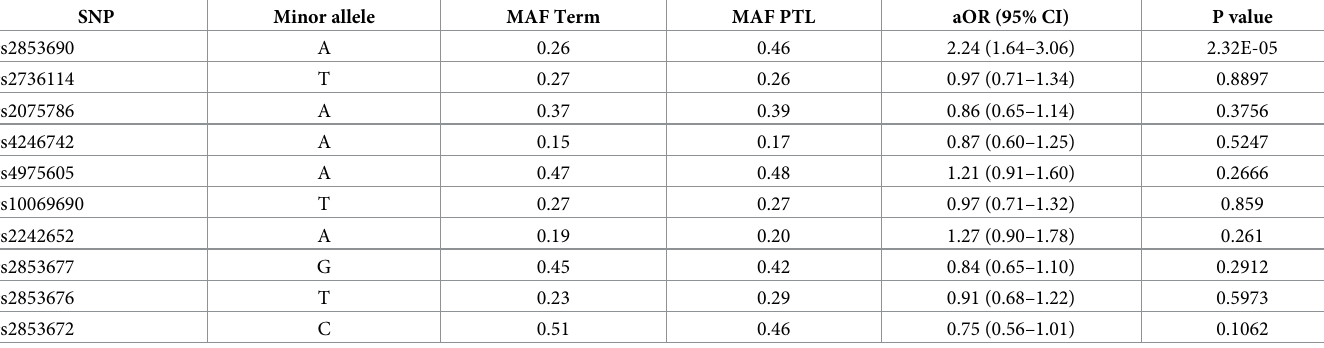
Table 4. Logistic regression results for maternal single locus allele frequencies among cases and controls and association with preterm labor.